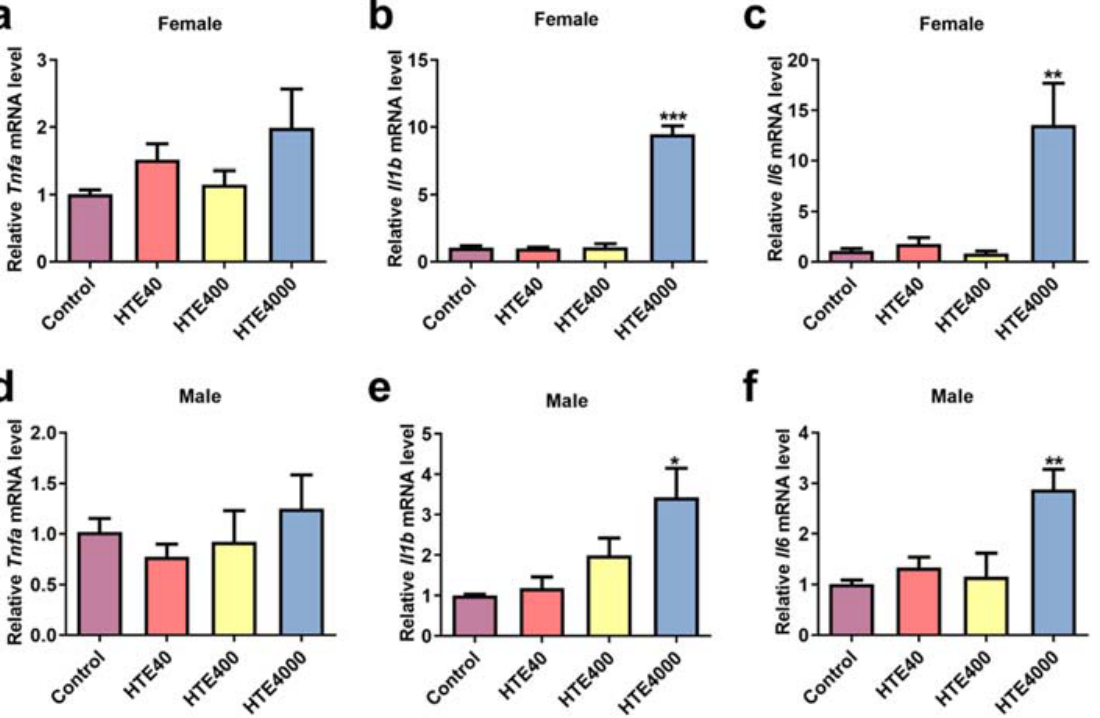
Figure 4. The relative mRNA expression of Tnfa , Il1b and Il6 in the kidneys in the HTE (40, 400 and 4000 mg/kg) subacute administration study. All data are presented as the mean ± SEM ( n = 6). The mRNA expression levels of ( a ) Tnfa , ( b ) Il1b and ( c ) Il6 for females. The mRNA expression levels of ( d ) Tnfa , ( e ) Il1b and ( f ) Il6 for males. Statistical significance was analyzed by using the Student’s t -test. Compared with the control, *, ** and *** represent 0.01 < p < 0.05, 0.001 < p < 0.01 and p < 0.001, respectively.